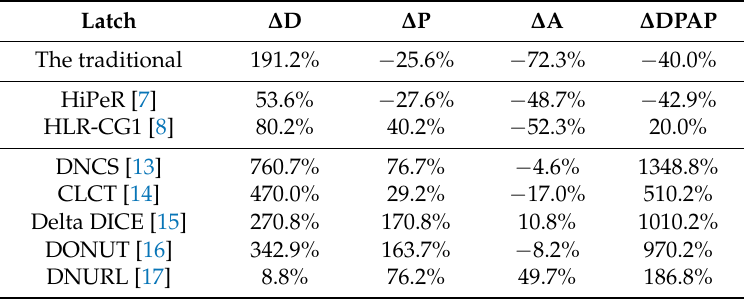
Table 2. Detailed cost comparisons between the proposed latch and other considered